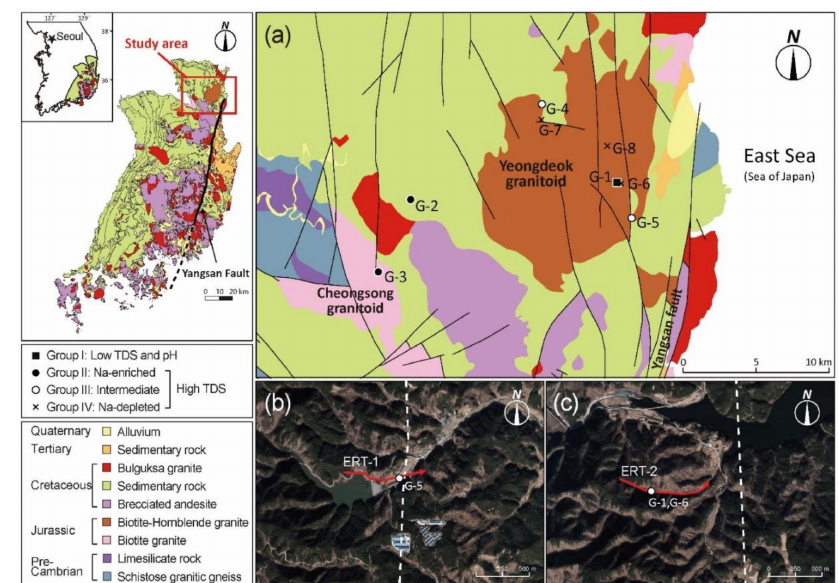
Figure 1. Study area at the southeastern part of South Korea. ( a ) Geological map with the locations of CO 2 -rich springs (G-1 to G-8; n = 8). The four groups were classified by pH, total dissolved solids, and Na contents in Figure 2. ( b , c ) show the geophysical survey lines around the G-5 (ERT-1) and the G-1 and G-6 (ERT-2), respectively. In ( a ), the black lines indicate faults, while in ( b , c ) the white dashed lines are